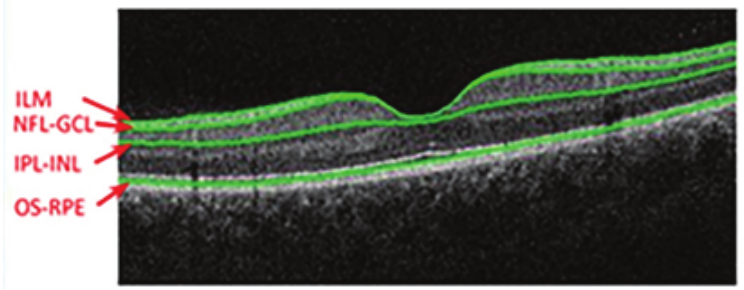
Figure 1. Full retinal layer scanning of a participant (right). RPE, retinal pigment epithelium; IPL, inner plexiform layer; ILM, inner limiting membrane; GCL, ganglion cell layer.